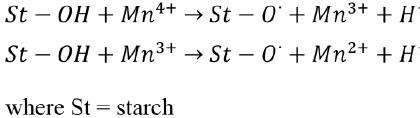
Figure 13. Radical generation in a potassium permanganate and sulphuric acid system. Adapted from [15].